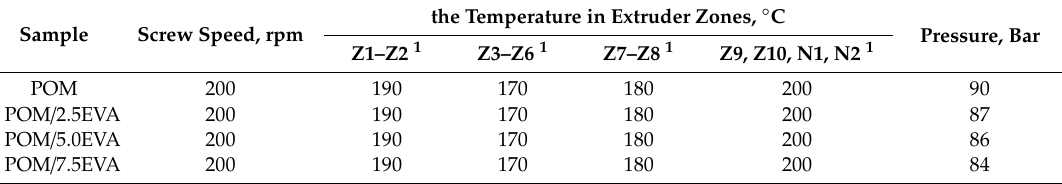
Table 1. Parameters of the extrusion for particular